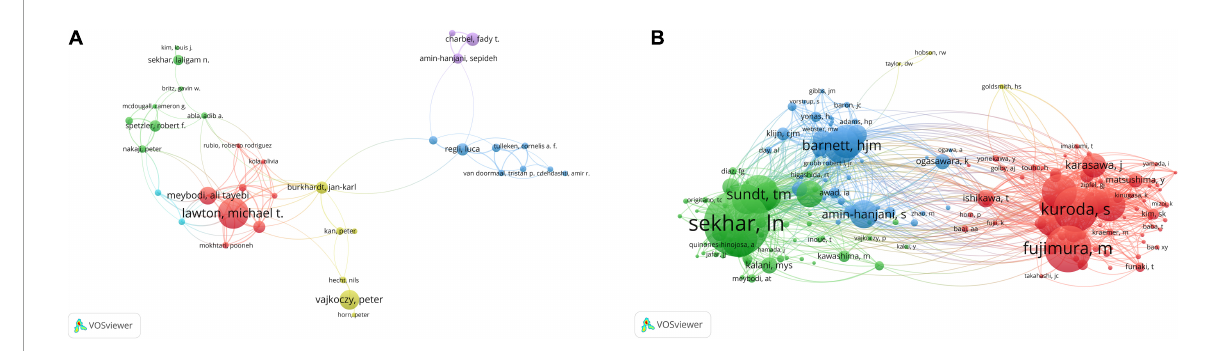
FIGURE5 Author analysis. (A) Author collaborative network analysis based on VOSviewer visual map. (B) Co-citation author network analysis based on VOSviewer visual map. The clusters of different colors reflect the cooperation among